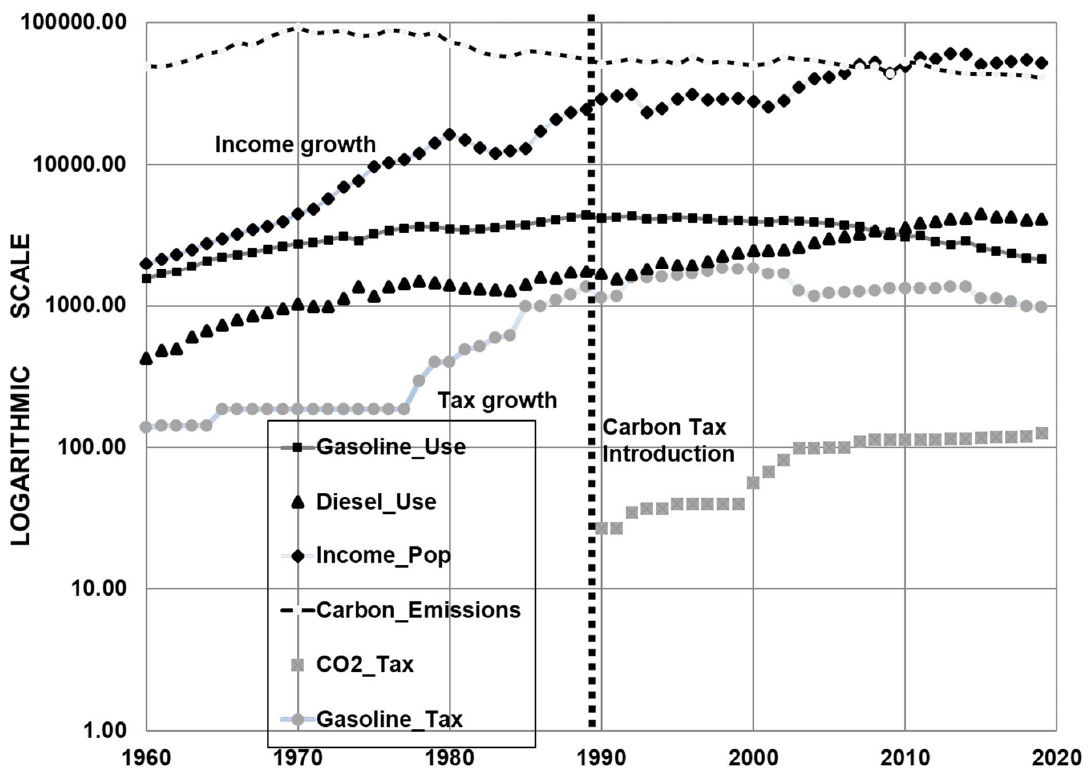
Figure 1. CO 2 emissions and other energy-use indicators: Sweden 1960–2019. Source: IEA [49] & UN data [47], World Bank (2020) [46].